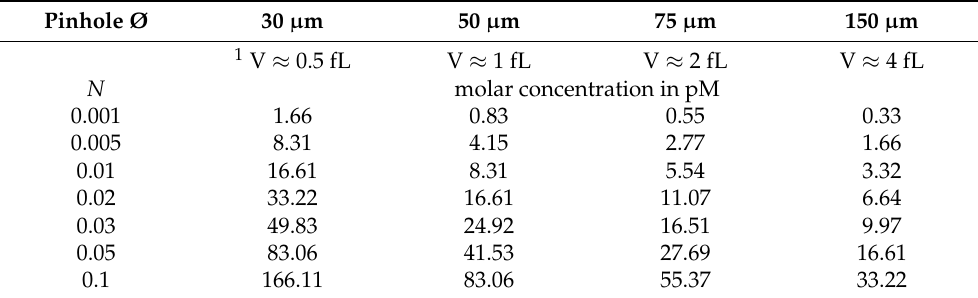
Table 1. Comparison of different molar molecule concentrations as determined from N for different confocal detection